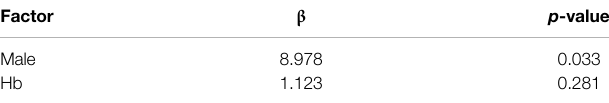
TABLE 5 | Multivariate factors associated with